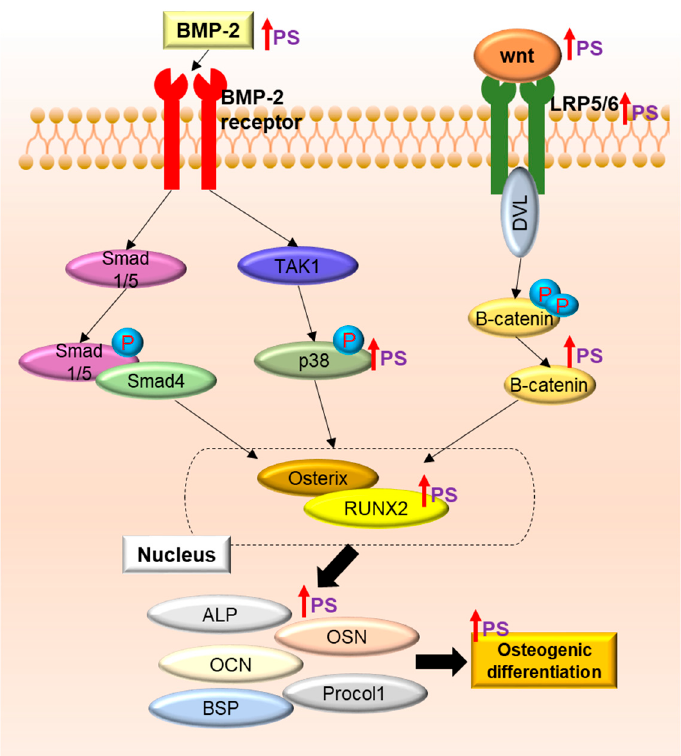
Figure 8. Schematic diagram of PS promotion of osteoblast differentiation ( ↑ : Upregulation function).